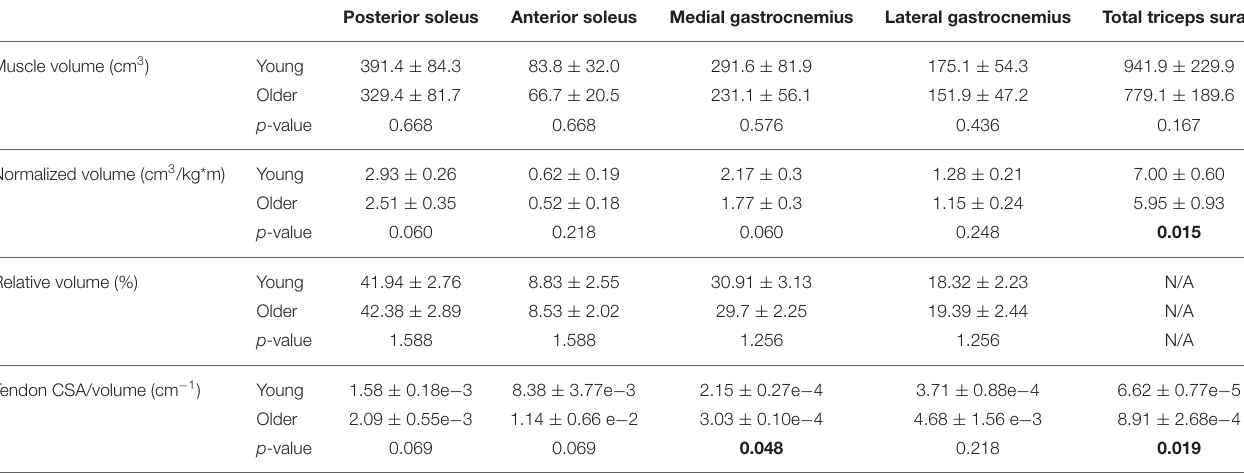
TABLE 2 | Triceps surae muscle volumes (mean ± standard deviation) compared between young and older